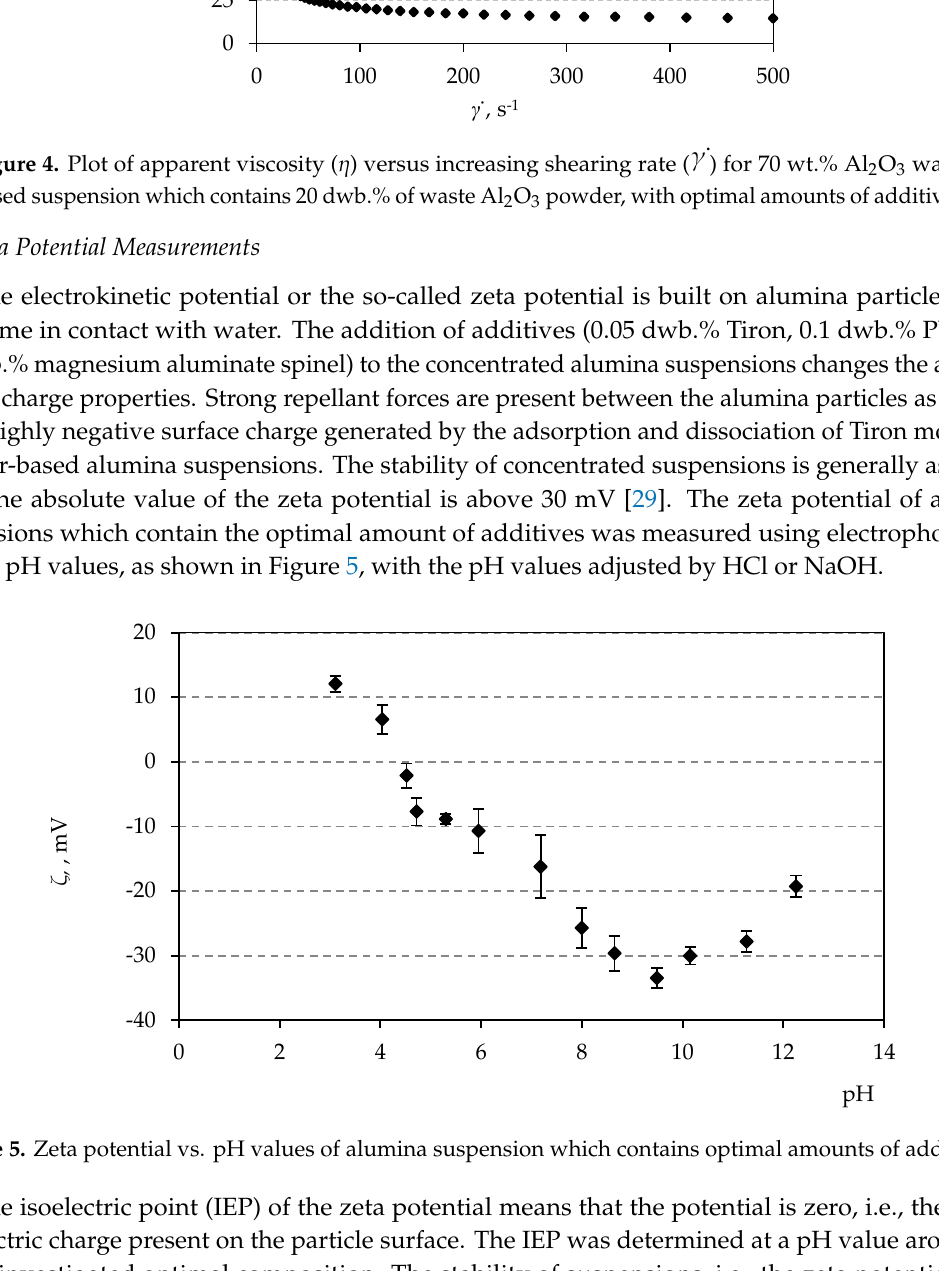
Figure 4. Plot of apparent viscosity ( η ) versus increasing shearing rate ( γ ̇ ) for 70 wt.% Al 2 O 3 water based suspension which contains 20 dwb.% of waste Al 2 O 3 powder, with optimal amounts of additives.